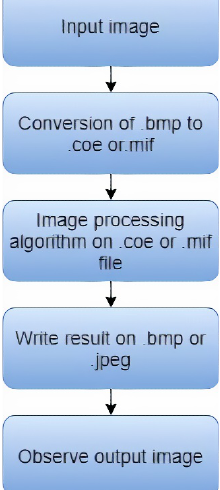
Figure 1. Sobel operator [29] .